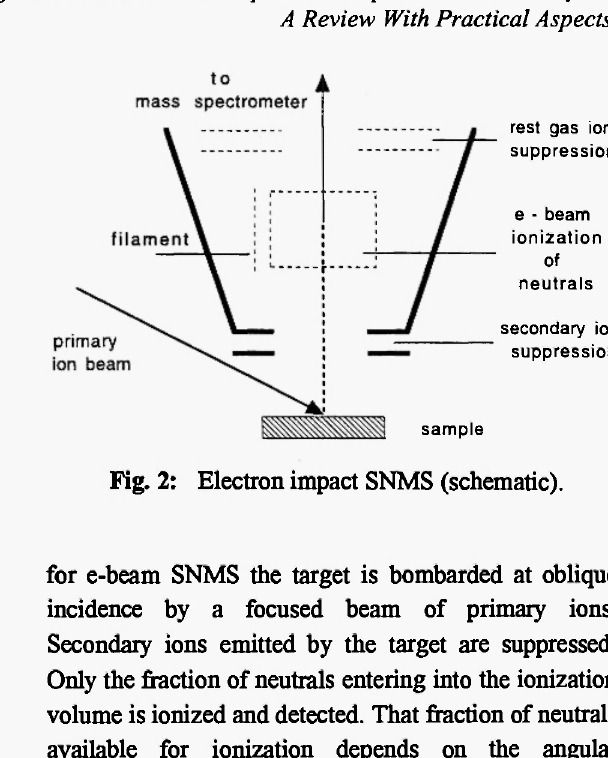
Fig. 2: Electron impact SNMS